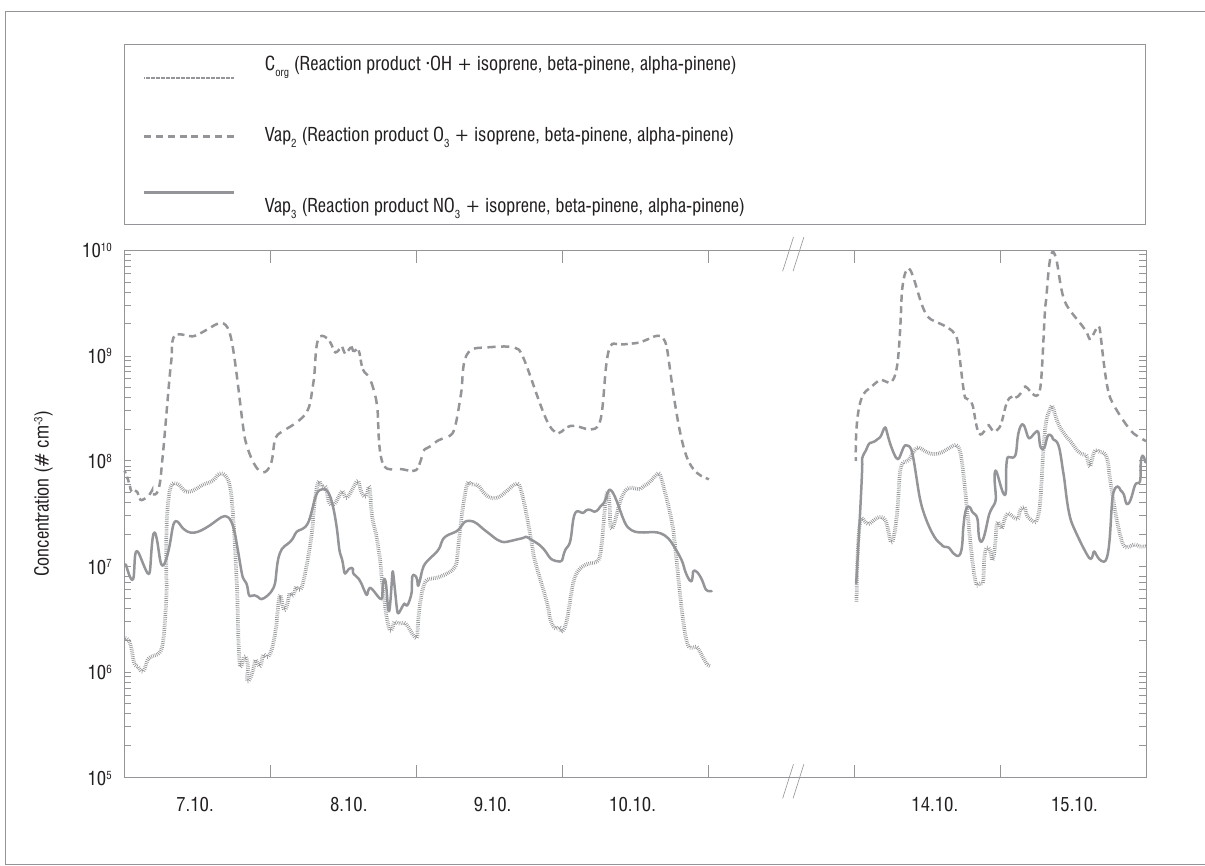
Figure 6. The low level of mixing, together with the higher concentrations of monoterpenes (Figure 5), is reflected in the high concentrations of the reaction products during the last 2 days. The concentrations of the reaction products generated from monoterpene and isoprene reactions (dashed line), showed similar behaviour with • OH (dotted line) and O 3 to those previously described for isoprene – a high formation rate during the day but, with effective mixing, the concentration decreased or did not continue to increase. The reaction products generated from • (solid line) showed monoterpene and isoprene reactions with NO 3 diurnal cycles driven by the vertical mixing. This process caused the concentration to be higher if the surface layer was very stable, which was the case during the last 2 days (14–15 October), especially during the night. The stable stratification also leads to strong vertical gradients, as the VOCs are emitted in the canopy. Particles The ability of the two selected nucleation mechanisms – kinetic and organic-induced nucleation – to reproduce the observed number concentration of particles was evaluated by holding the nucleation coefficients K (in Equation 1) and P (in Equation 2) constant for all simulated days. The modelled events, together with the observations, are shown in Figure 7. To allow more detailed comparison, the formation ) and the growth rate for 10–20-nm particles rate of 10-nm particles (J 10 were calculated from observations and both simulations for each day (Table 2).